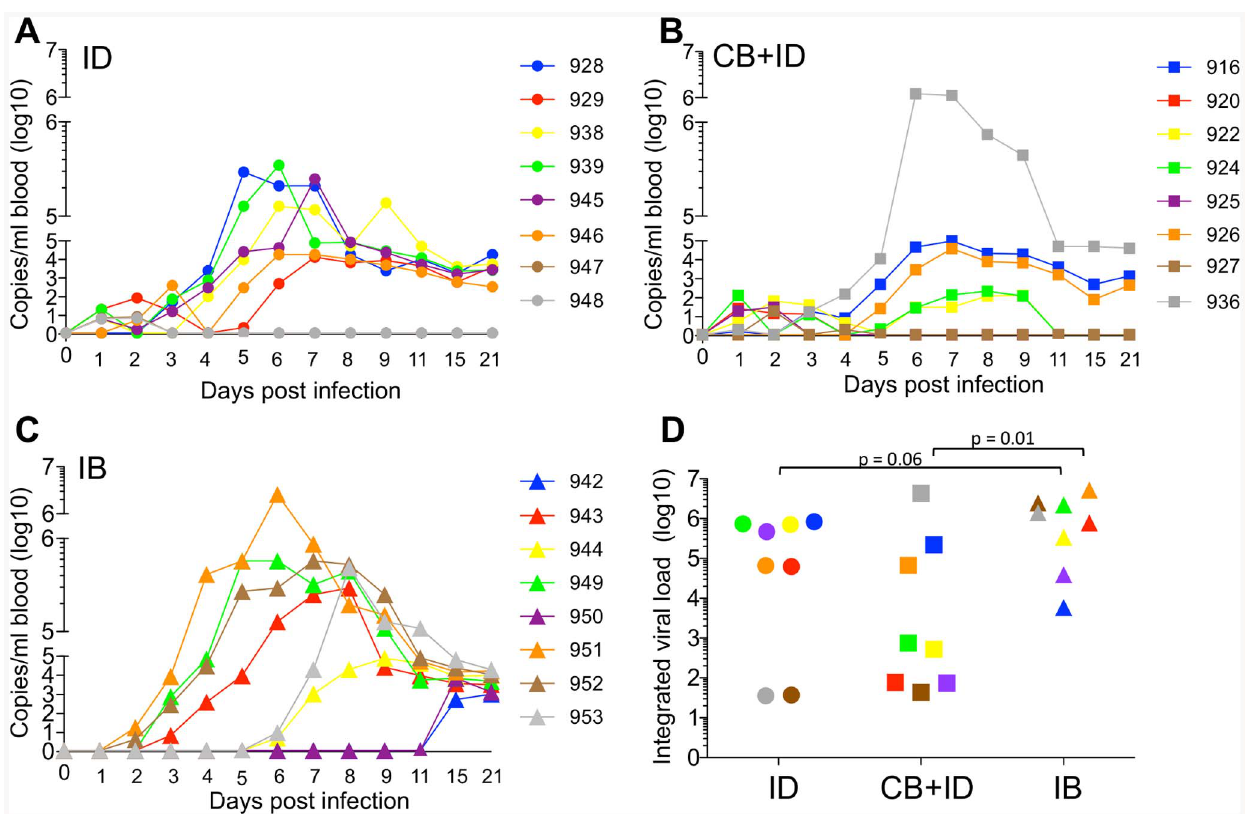
Figure 1. Measurement of viraemia in needle and C.nubeculosous - infected sheep. BTV viral RNA was detected in blood by qRT-PCR at 0–9, 11, 15, 21 dpi. The number of BTV copies per ml of blood is reported for each sheep with a specific color and symbol shape. The 3 infected group are represented by a distinct symbol, i.e. a circle for the intradermal needle- inoculation group (ID, A ), a square for the control C. bite + intradermal needle- inoculation group (CB + ID, B ), and triangle for the infected C. bite group (IB, C ). In D , the viral load over the 21- day monitoring period was integrated for each sheep using a calculation of area under the curve (color and shape symbol as in A, B, C). Statistical comparisons between 2 groups were done with a Mann-Whitney U test and the p values are reported to show significance and major tendencies.